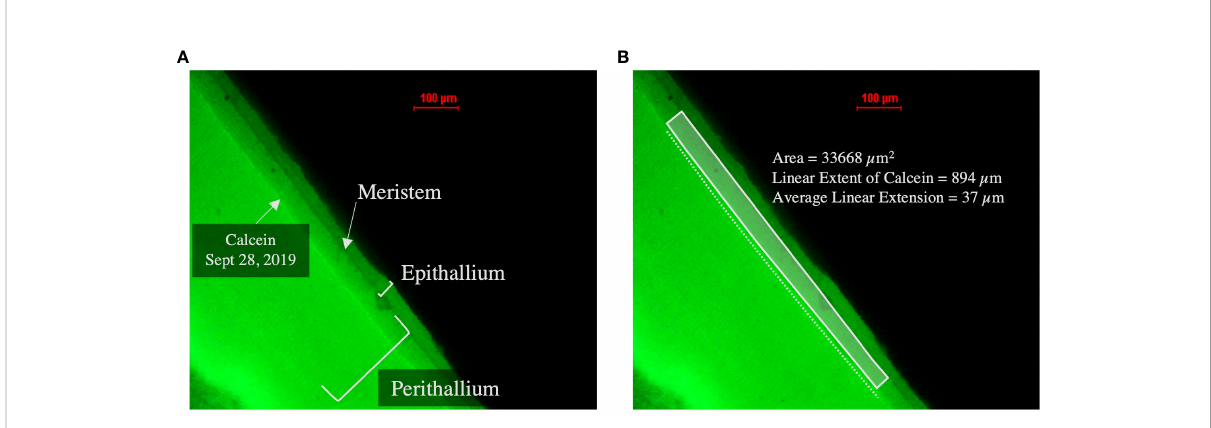
FIGURE 5 Fluorescent microscope images of representative C. compactum sample. (A) Image depicting calcein line (indicating initiation of experimental period September 28, 2019), meristem, epithallial skeleton and perithallial skeleton. (B) Image depicting calculation of average linear extension, measured by obtaining an area above the calcein line and below the meristem divided by the lateral distance of the calcein marker below this area.